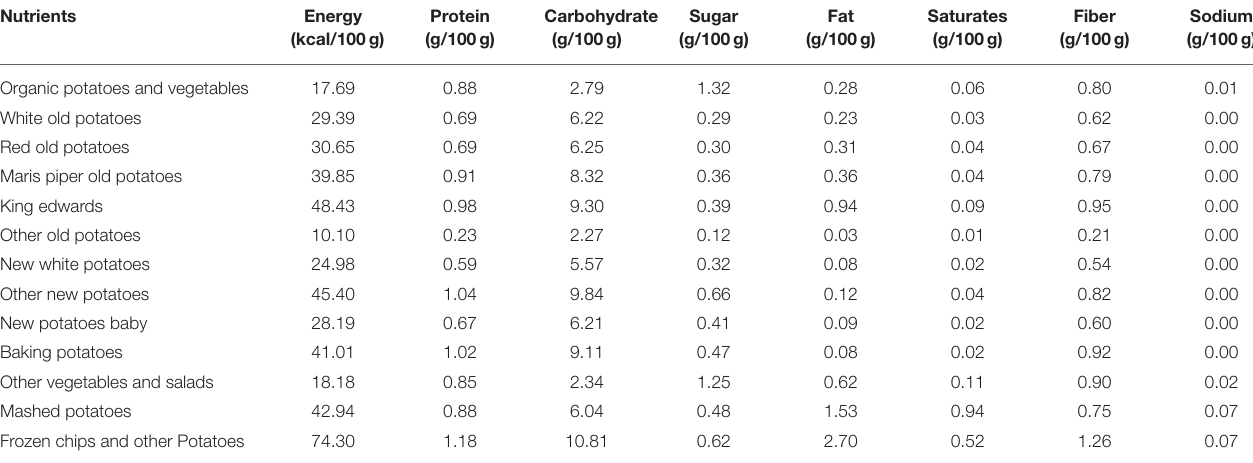
TABLE 3 | Average nutrient contents per 100 grams of potato product. Nutrients Energy